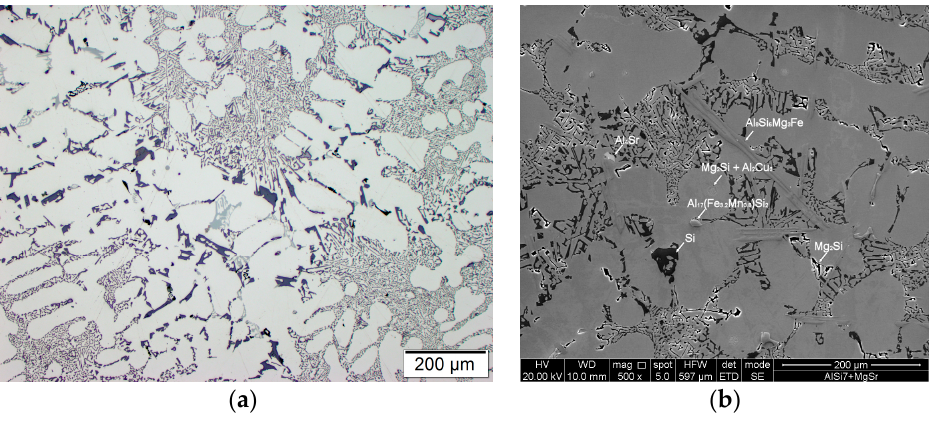
Figure 6. Structure of AlSi7Mg0.6 after addition 2 wt % Mg and 0.03 wt % Sr, ( a ) LM; ( b ) SEM.